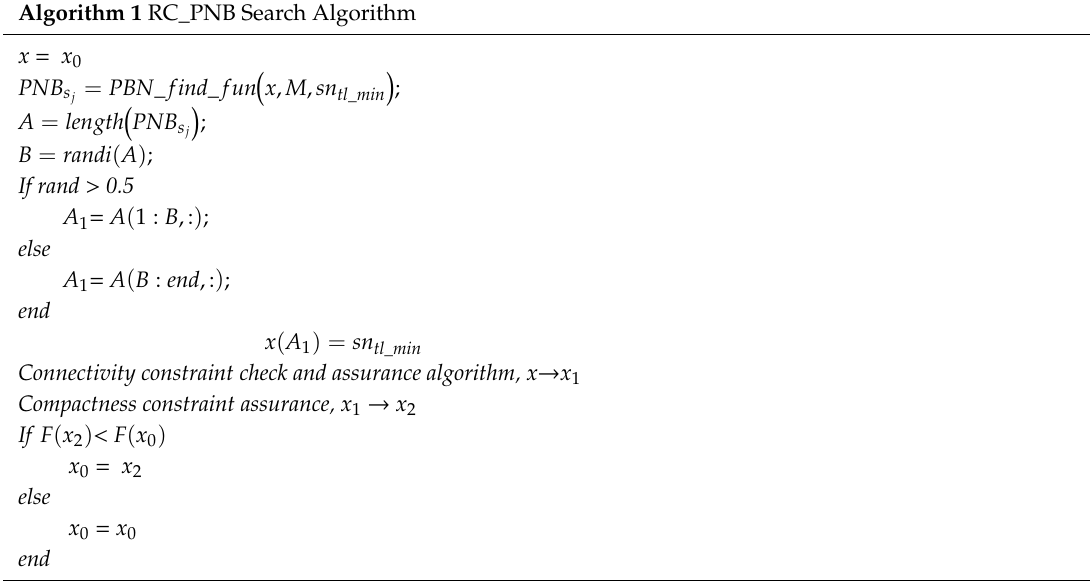
Algorithm 1 RC_PNB Search Algorithm